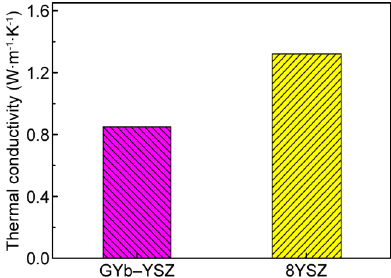
Fig. 6 Thermal conductivities of TBCs with GYb–YSZ or 8YSZ at 1000 ℃ .